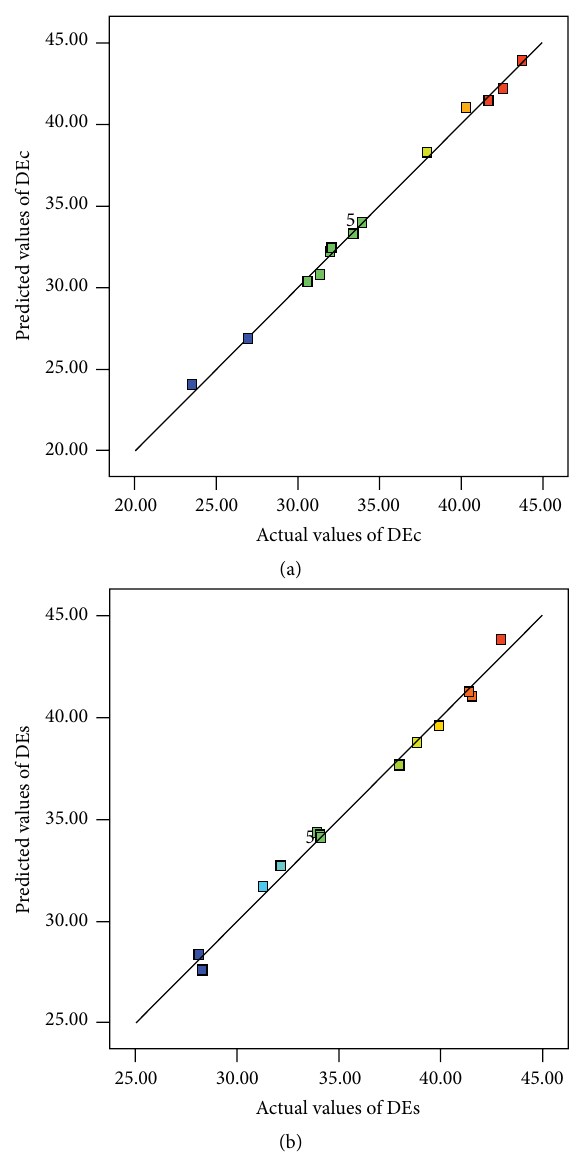
Table 1: Variable levels and the response of DE of pectin based on pH value, extraction temperature, and time.